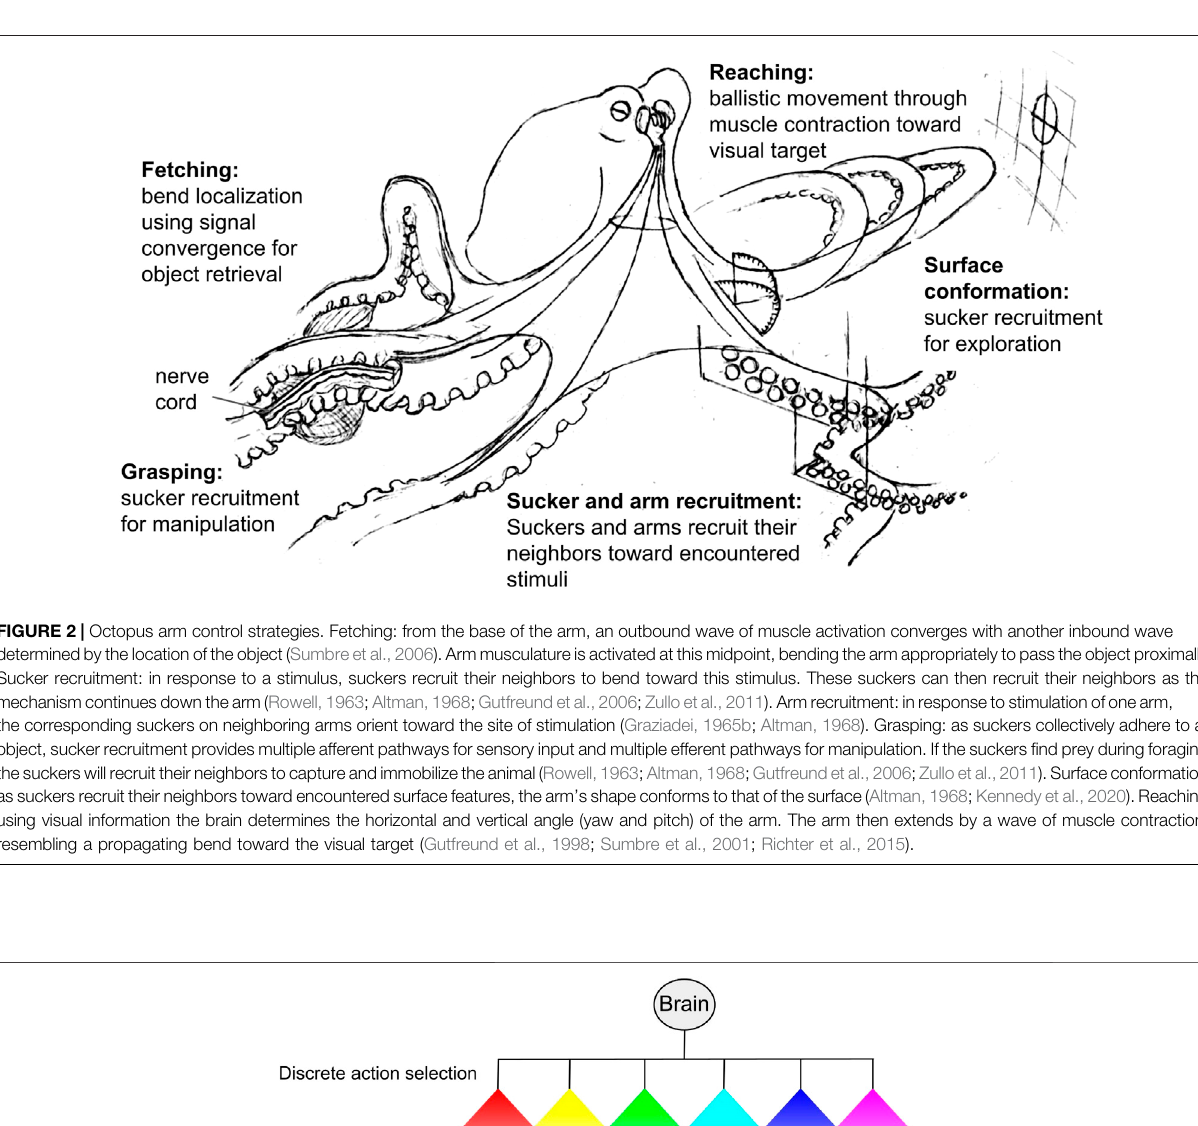
Frontiers in Robotics and AI |